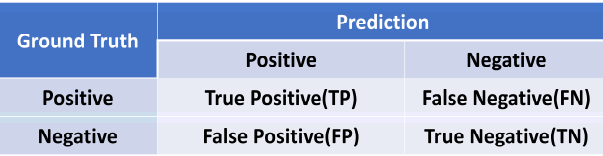
Figure 12. Confusion matrix.